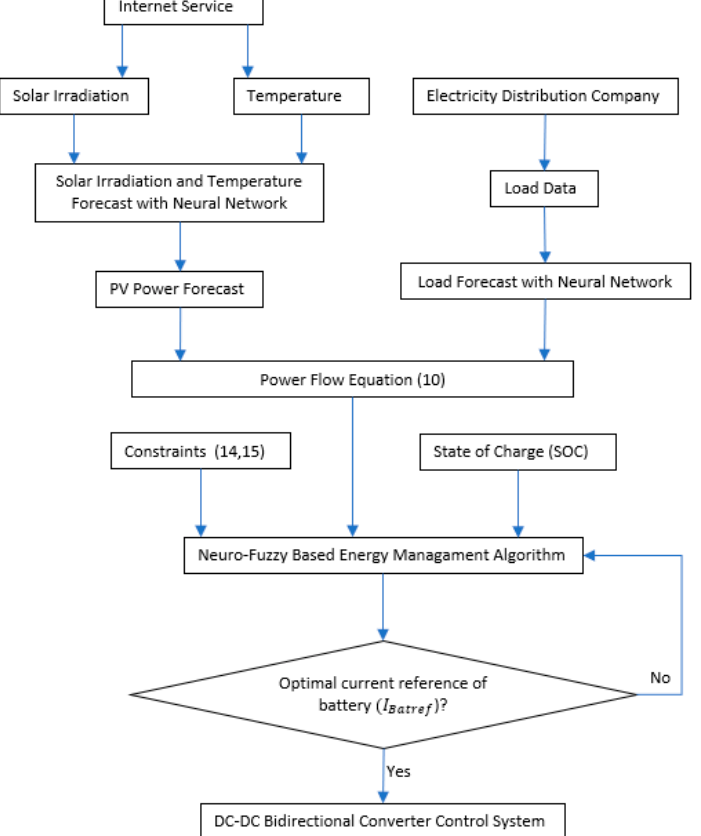
Figure 9. MPC-inspired energy management algorithm flowchart.